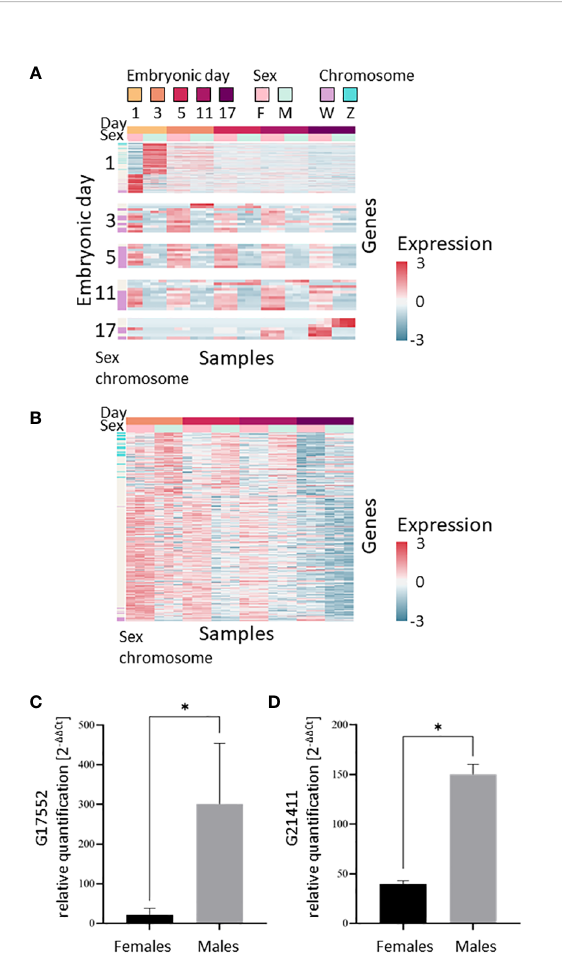
FIGURE 3 Transcriptional differences between the sexes during embryonic development of M. rosenbergii . (A) Expression level heatmap of the genes that are differentially expressed between males and females on each sampling day ( t -test FDR<0.05, |fold change|>1). Genes (rows) were separated by the embryonic day in which they displayed differential expression. On each embryonic day, genes were sorted by the t -statistic. Genes located on scaffolds that were identi fi ed as part of the sex chromosomes are indicated in mauve (W chromosome) or blue (Z chromosome) on the sex chromosome bar on the left. (B) Expression level heatmap of the genes that are differentially expressed between males and females during days 3 – 17 of embryonic development (paired t -test, pairing by days, FDR<0.05, |fold change|>1). Genes were sorted by the t - statistic. In both A and B, colors represent standardized expression levels; see bar on the right. (C, D) Differentially expressed genes in vitro validation. Relative quanti fi cation of (C) g17552 at day 3 and (D) g21411 at day 11 in female and male embryos. Error bars represent the standard error of the means, and asterisks represent the statistically signi fi cant differences ( P < genes g17552 and g21411 were veri fi ed by qPCR and found to be male-biased, as predicted by the in-silico differential expression analyses. The relative transcript levels of g17552 and g21411 were signi fi cantly higher ( P < 0.05) in males than females on day 3 and day 11, respectively (Figures 3C, D).